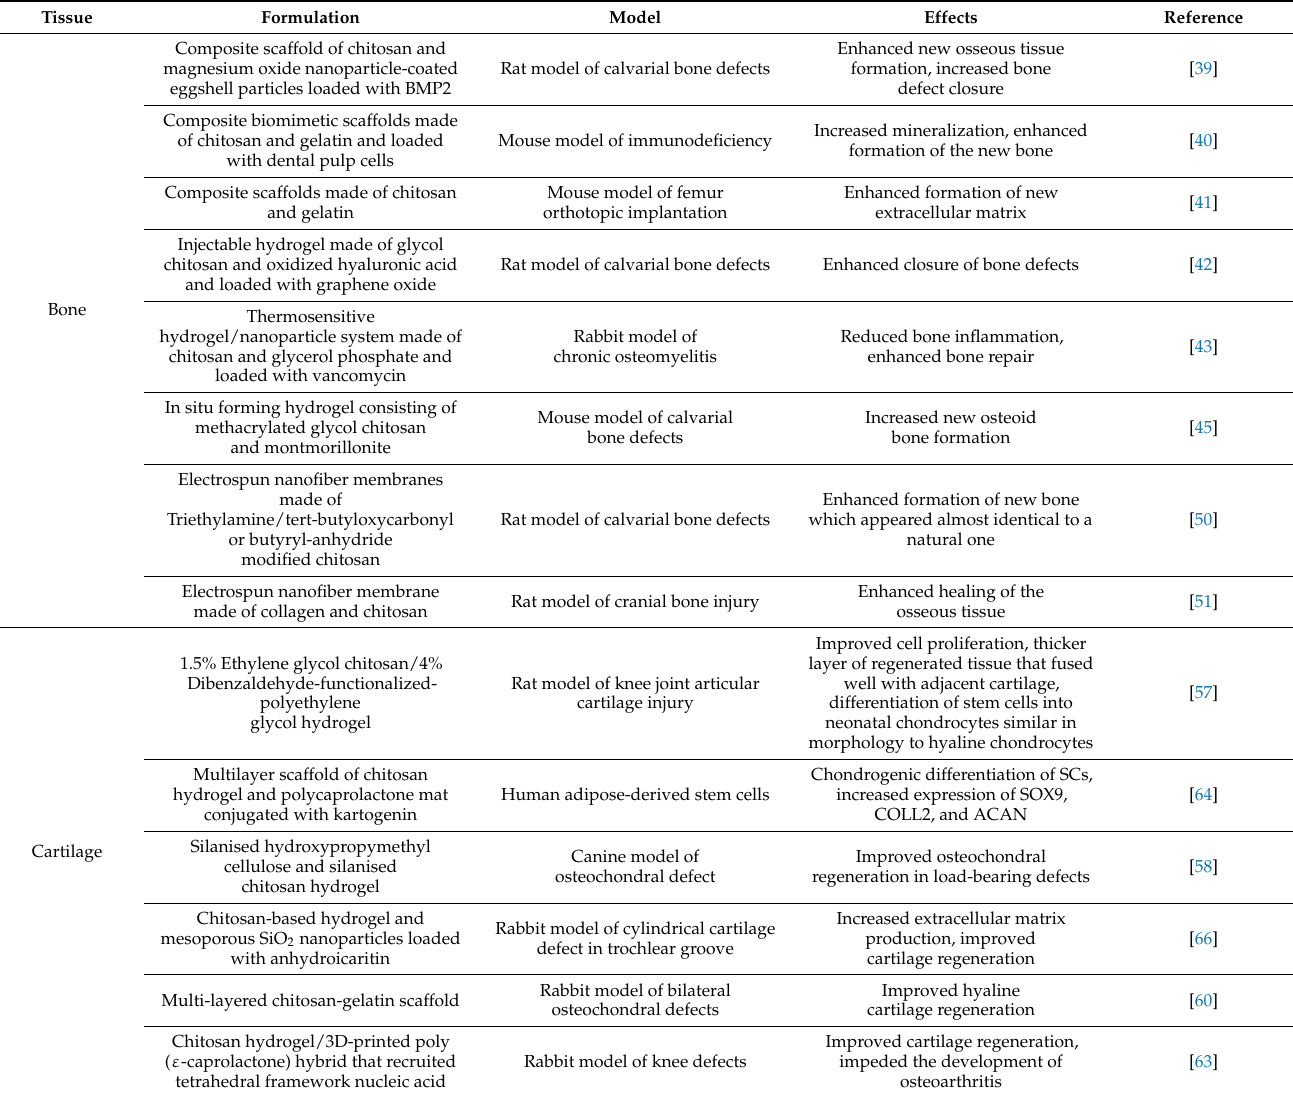
Table 1. Use of different chitosan formulations for bone, cartilage, and dental tissue regeneration.